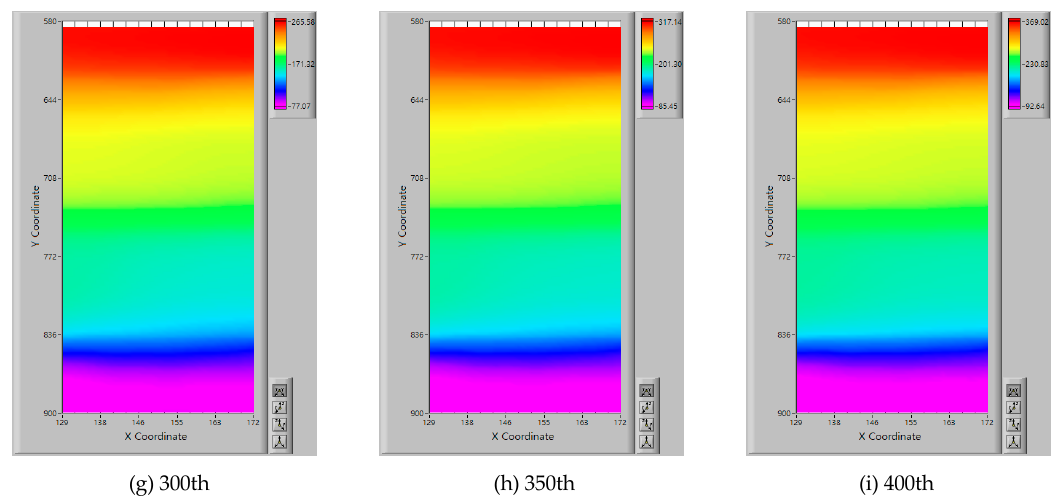
Appl. Sci. 2019 , 9 , x FOR PEER REVIEW Figure 15. Y direction displacement distributions from DIC measurement. Figure 15. Y direction displacement distributions from DIC measurement.